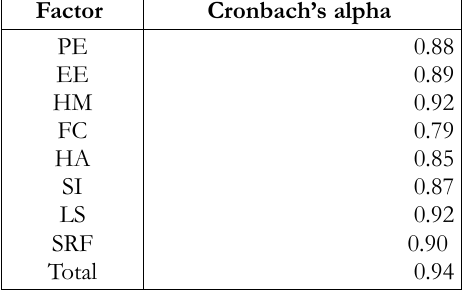
Table 3. Reliability of the questionnaire